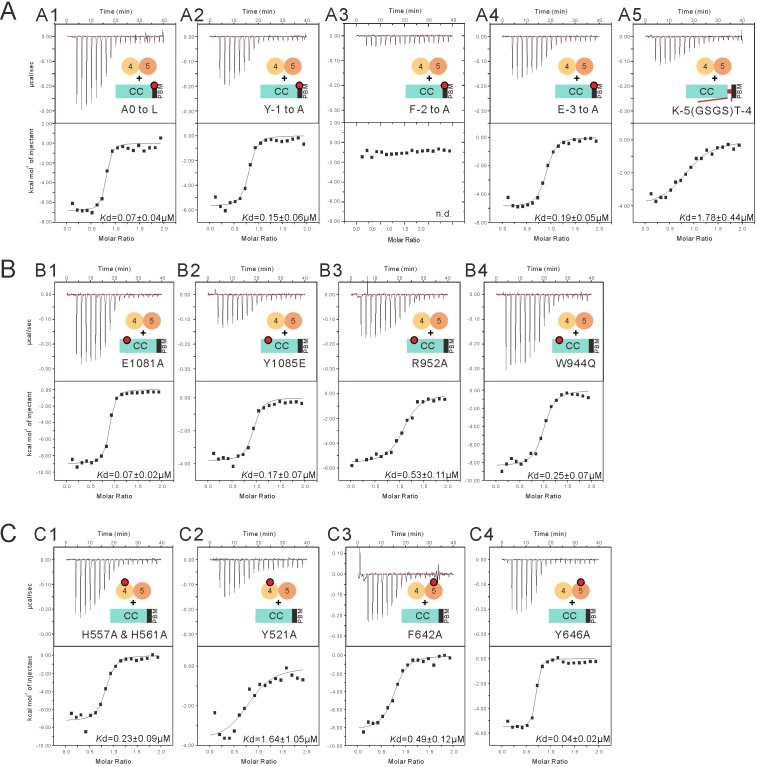
Impact of the mutations on the binding affinity between INAD PDZ45 and the NORPA CC-PBM.(A) ITC-based measurements comparing the binding affinities between INAD PDZ45 and the NORPA CC-PBM with different mutations in its PBM. (A1) A0 was mutated to L. (A2) Y-1 was mutated to A. (A3) F-2 was mutated to A. (A4) E-3 was mutated to A. (A5) A flexible GSGS sequence was inserted between CC and PBM. (B) ITC-based measurements comparing the binding affinities between INAD PDZ45 and the NORPA CC-PBM with different mutations in the CC region as indicated. (C) ITC-based measurements comparing the binding affinities between different INAD PDZ45 mutants and the NORPA CC-PBM.